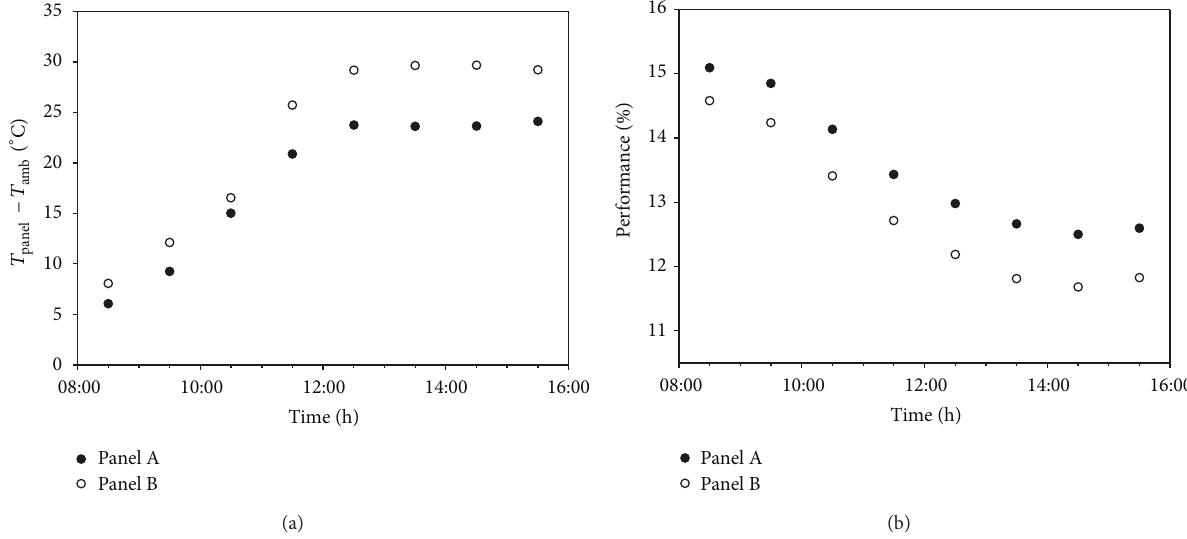
the lowest forced velocity, owing to the fact that air by forced convection cools the panel, as Figure 7